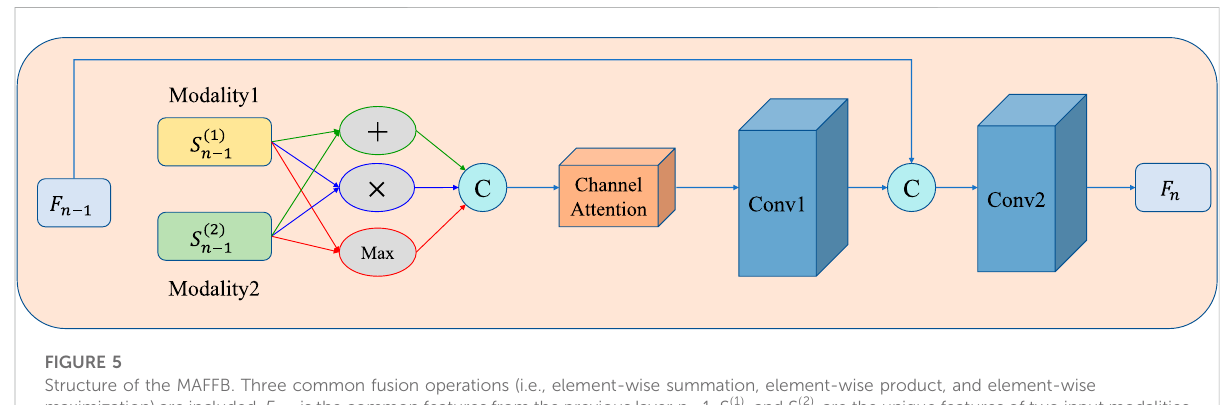
FIGURE 5 Structure of the MAFFB. Three common fusion operations (i.e., element-wise summation, element-wise product, and element-wise maximization) are included. F n − 1 is the common features from the previous layer n − 1. S ( 1 ) n − 1 and S ( 2 ) n − 1 are the unique features of two input modalities from layer n − 1. C means concatenation. F n is the obtained common features of the present layer n